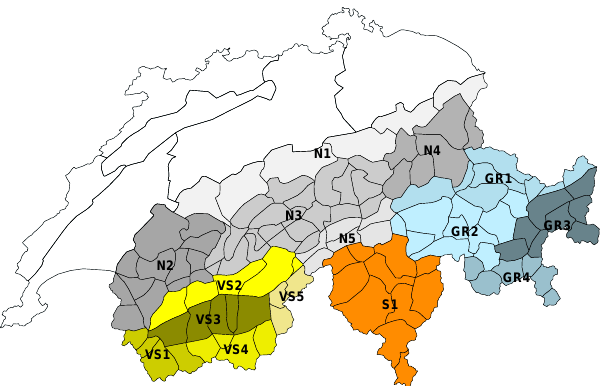
Figure 2. Map of Switzerland showing the forecast areas used to regionalize the avalanche bulletin (smaller polygons) and the 15 re- gions used for analysis in this paper (colored and